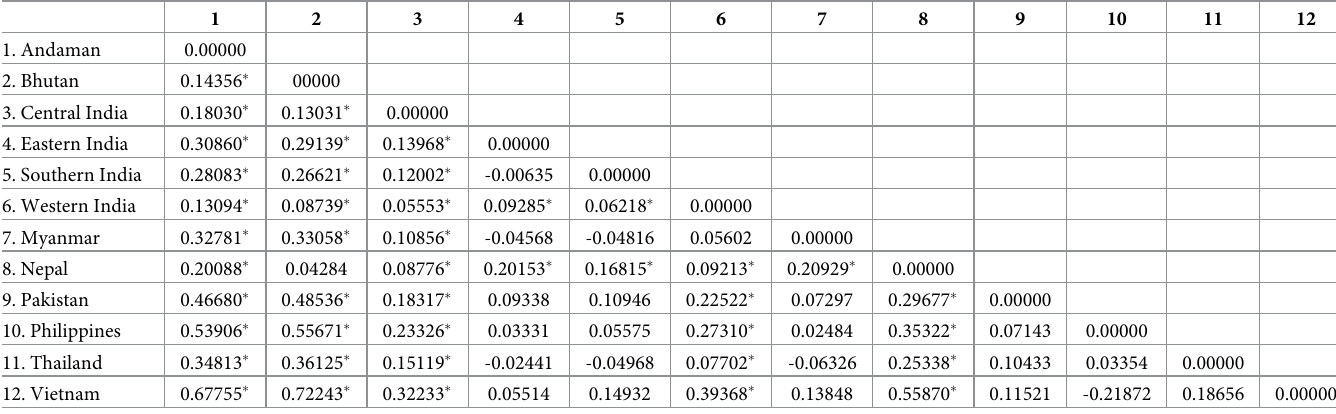
Table 3. Pairwise FST values of I2 cattle of Andaman and different regions of Indian subcontinent and Island Southeast Asian countries.